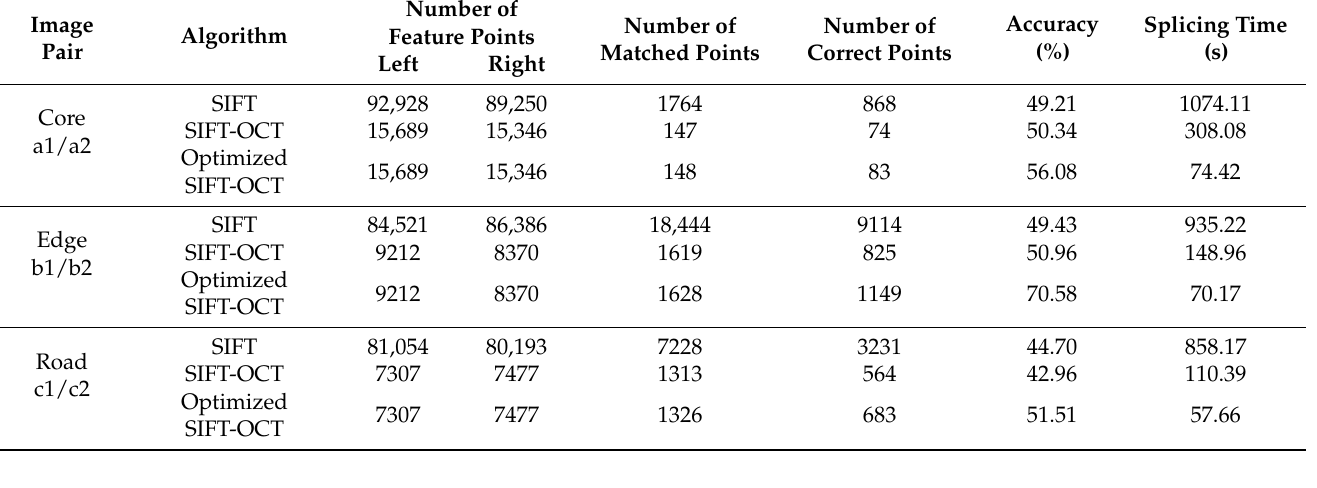
Table 1. Comparison of image stitching algorithm efficacy.